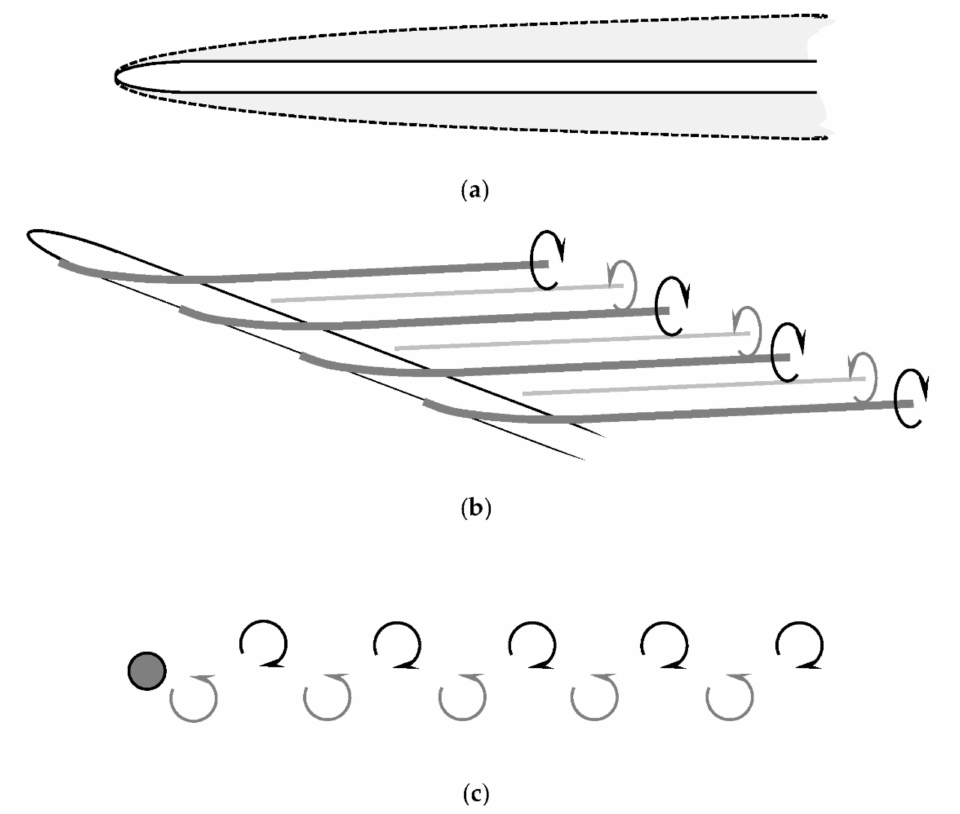
Figure 7. Schematic drawings of the three categories of flow for cylinders across the range of yaw angles: ( a ) boundary layer forming on a cylinder aligned with the flow, γ = 0 ◦ ; ( b ) top view of the attached vortices alternating from one side of the cylinder to the other; ( c ) side view of the classic K á rm á n vortex street for a cylinder that is oriented perpendicular to the flow, γ = 90 ◦